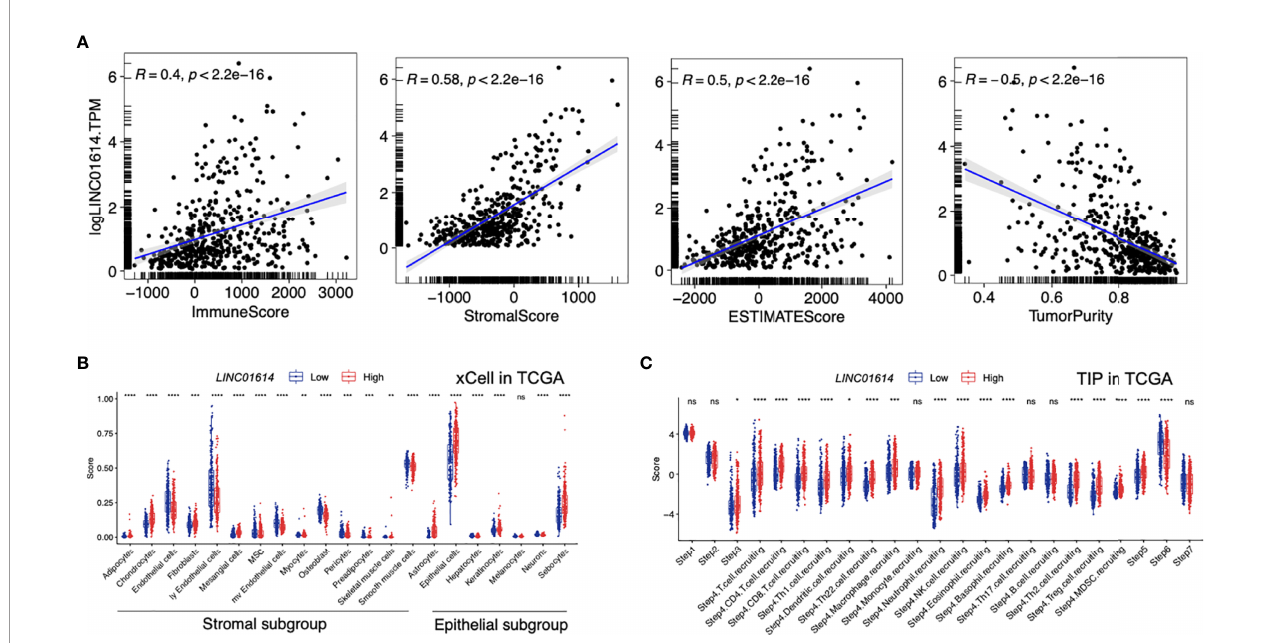
FIGURE 10 | TME components in distinct LINC01614 levels in PTC patients. (A) Comparison of the immune score, stromal score, microenvironment score, and tumor purity in different LINC01614 level groups. (B) Comparison of the stromal and epithelial components quanti fi ed by xCell in the different LINC01614 level groups. (C) Comparison of the activity of the cancer immunity cycle between the LINC01614 high and LINC01614 low groups. ns, no-signi fi cance, *p < 0.05, **p < 0.01, ***p < 0.001, ****p <